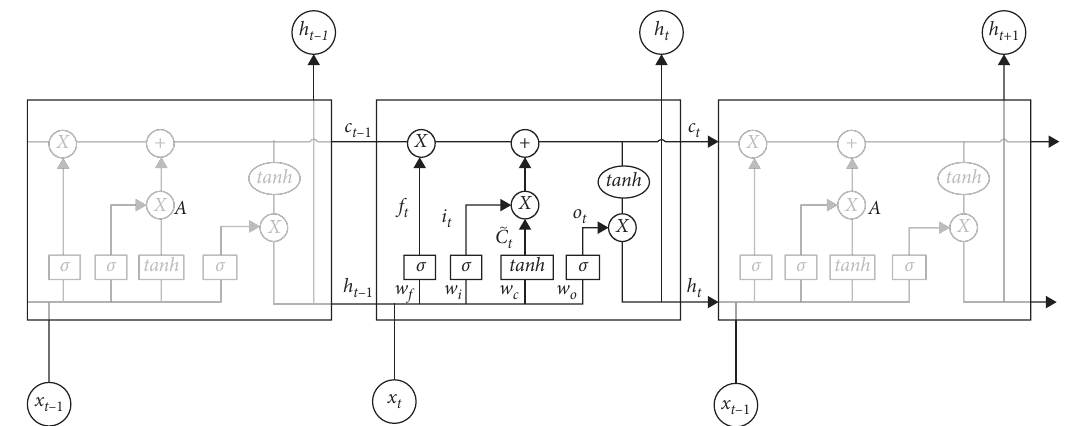
Figure 9: The internal structure of an LSTM cell.